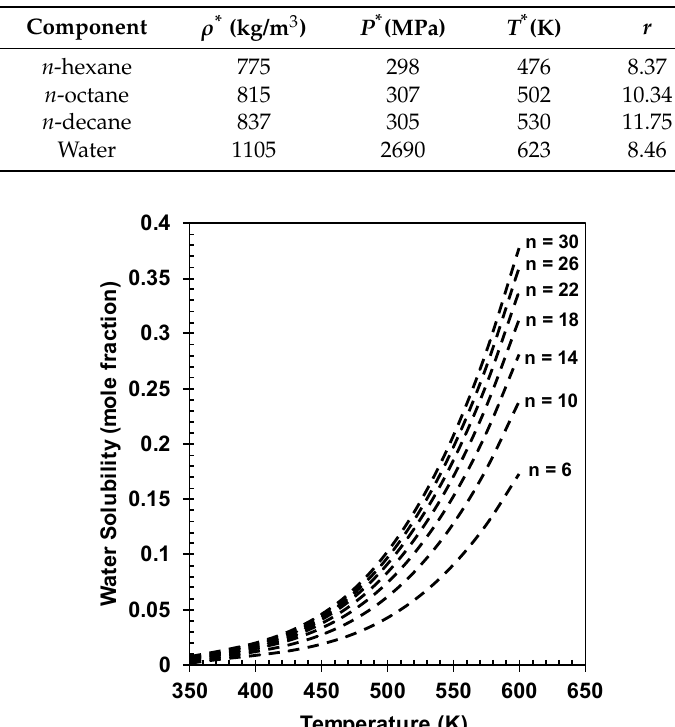
Table 1. Reference state parameters used in calculation [36].